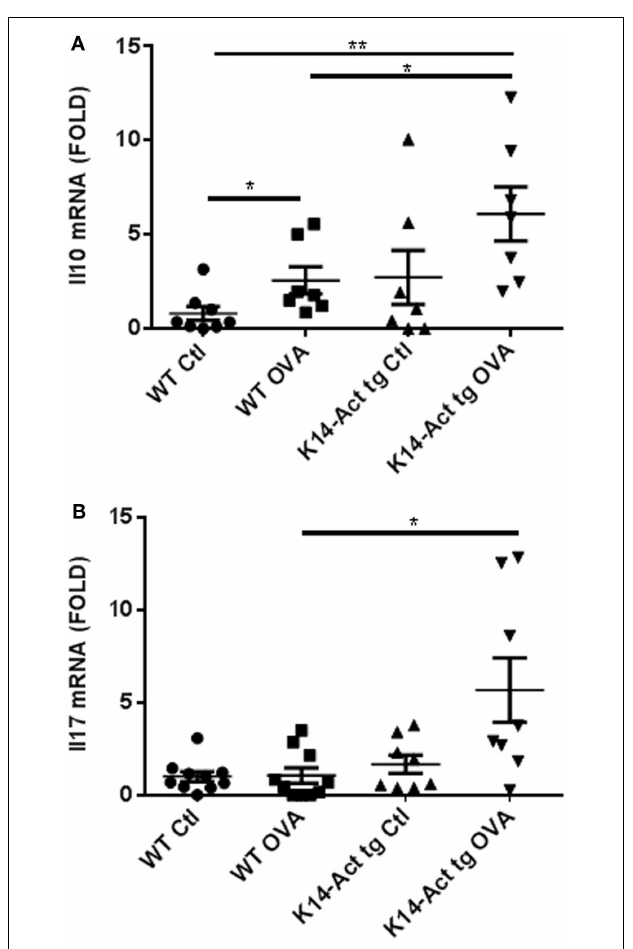
FIGURE 7 | Il10 and Il17A mRNA expression is increases in OVA-treated K14-Act mice . Skin biopsies fromWT and K14-Act mice, vehicle, or OVA-treated, were collected and used for RNA isolation and subsequent generation of cDNA. Real-time PCR was performed using primers specific for mIl10 (A) and mIl17A (B) . Ct values were normalized to expression levels of the hprt house-keeping gene.The experiment was realized in groups of 7–10 mice. Results are presented in a scatter graph and mean values ± SEM are shown. Statistically significant differences were calculated with the Mann–Whitney U -test ( p < 0.05*, p <